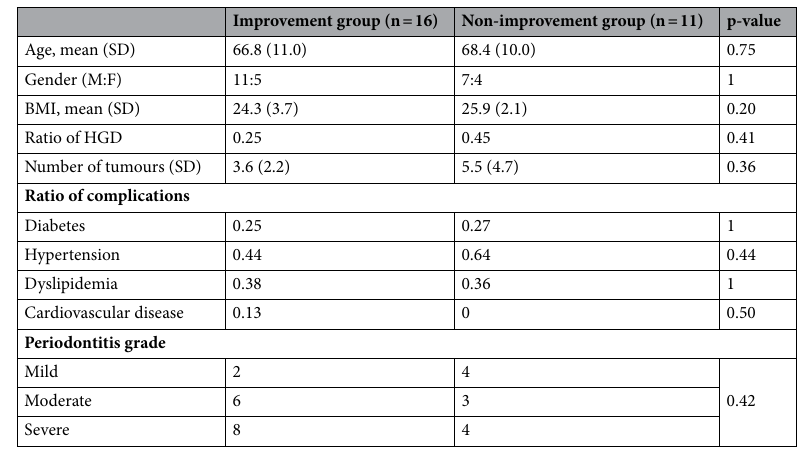
Table 1. Clinical characteristics of